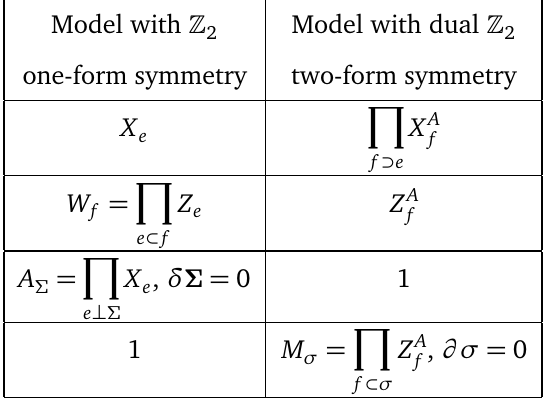
on all edges intersecting with a closed e two-form symmetry, generated by membrane opera- 2 Model with (cid:90) Model with dual (cid:90) 2 2 one-form symmetry two-form symmetry (cid:89) X X A e f f ⊃ e (cid:89) = W Z Z A f e f e ⊂ f (cid:89) A Σ = X , δ Σ = e e ⊥ Σ